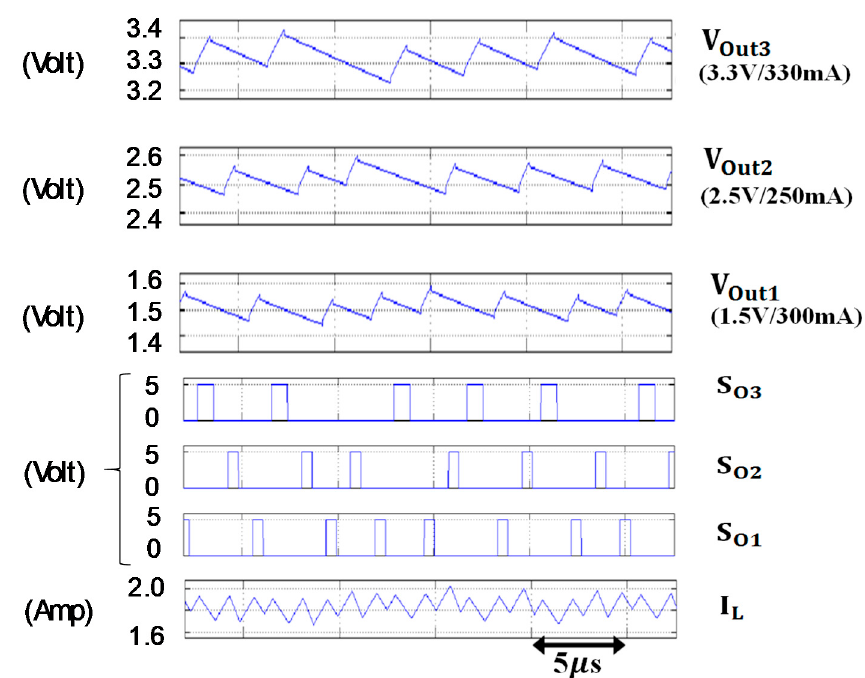
Figure 7. Simulated waveforms of output voltages, gate-drive voltages for output switches, and inductor current while sampled V error_sum is sensed to be within V ref + > V error_sum > V ref − .